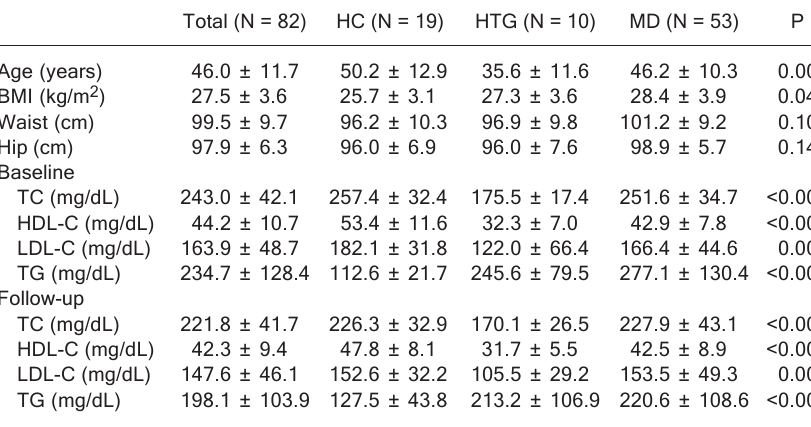
Table 1. Baseline, post-intervention and changes in plasma lipids as a function of type